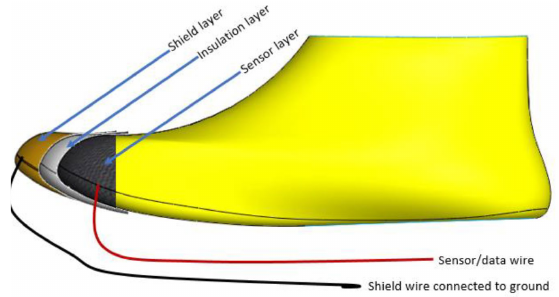
Figure 4. Sensor layer and wire